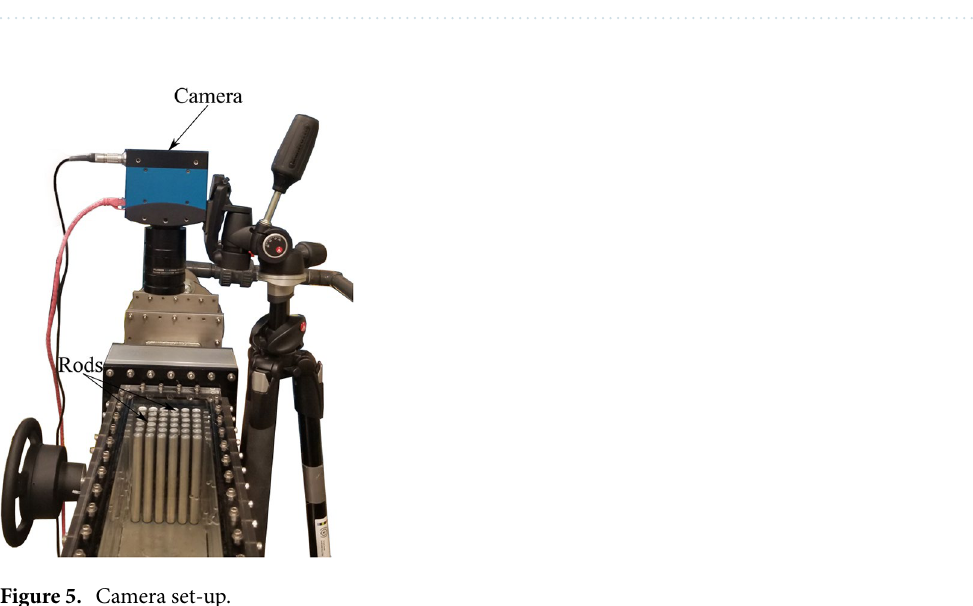
Figure 5. Camera